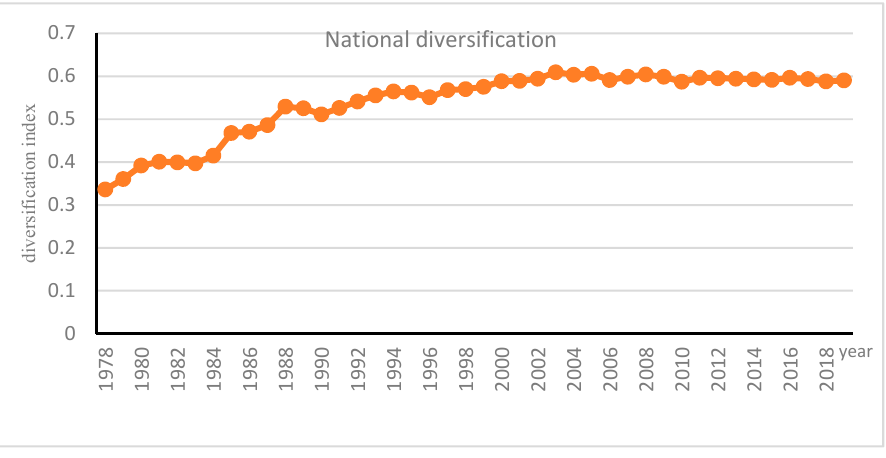
Figure 1. Trend of AD in China.